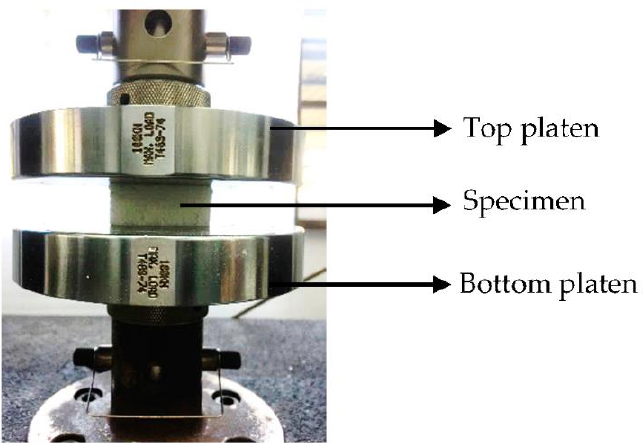
Figure 2. Quasi-static compression testing of specimen.